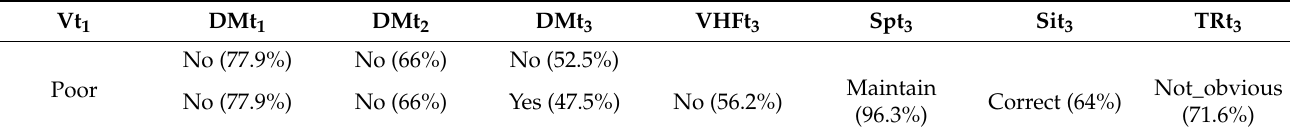
Table 8. Maximum posterior probability distribution of act